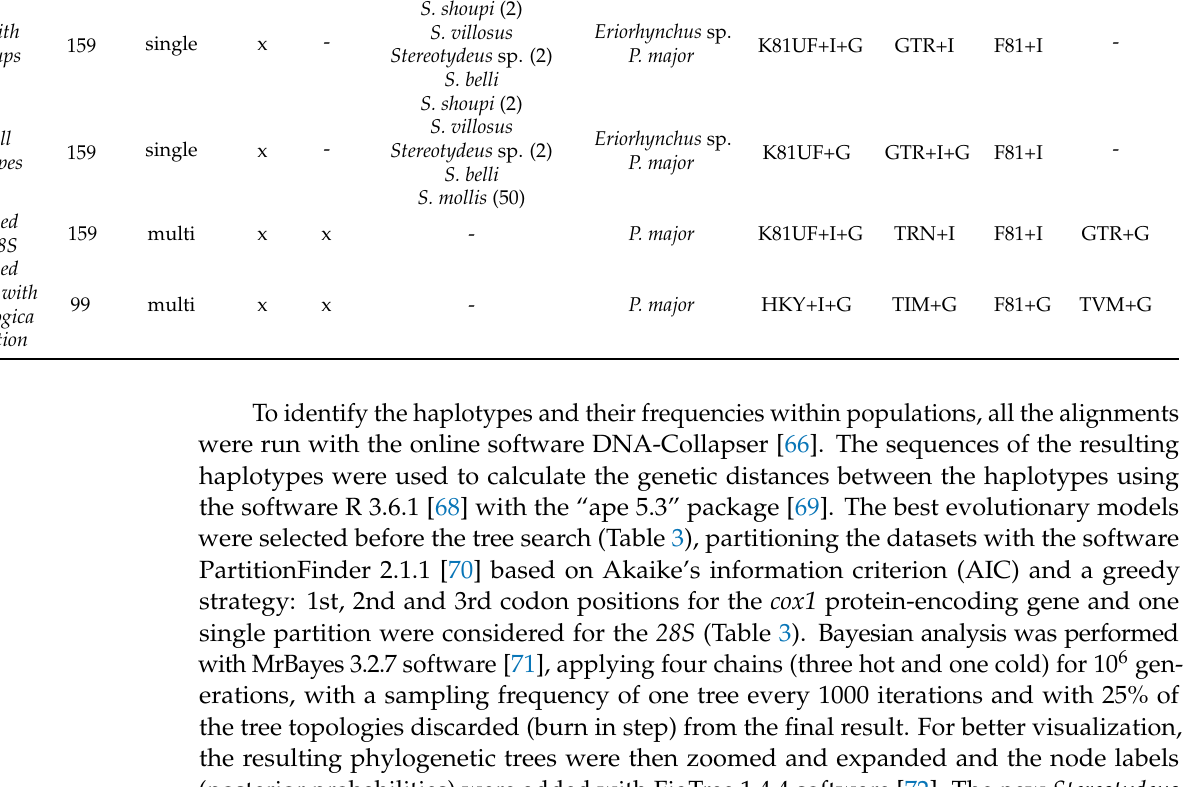
Table 3. List of the datasets (single and multilocus), number of new sequences obtained and used in each dataset ( n. ), markers, reference sequences (Ref.) and outgroups used for the analyses and models of nucleotide evolution that best fitted, divided according to the partition applied and to the respective tree search optimization criteria. n